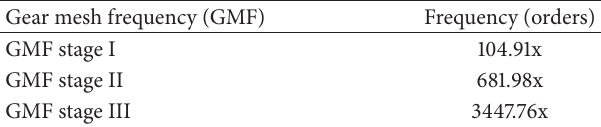
Table 6: Forcing frequencies for each stage.